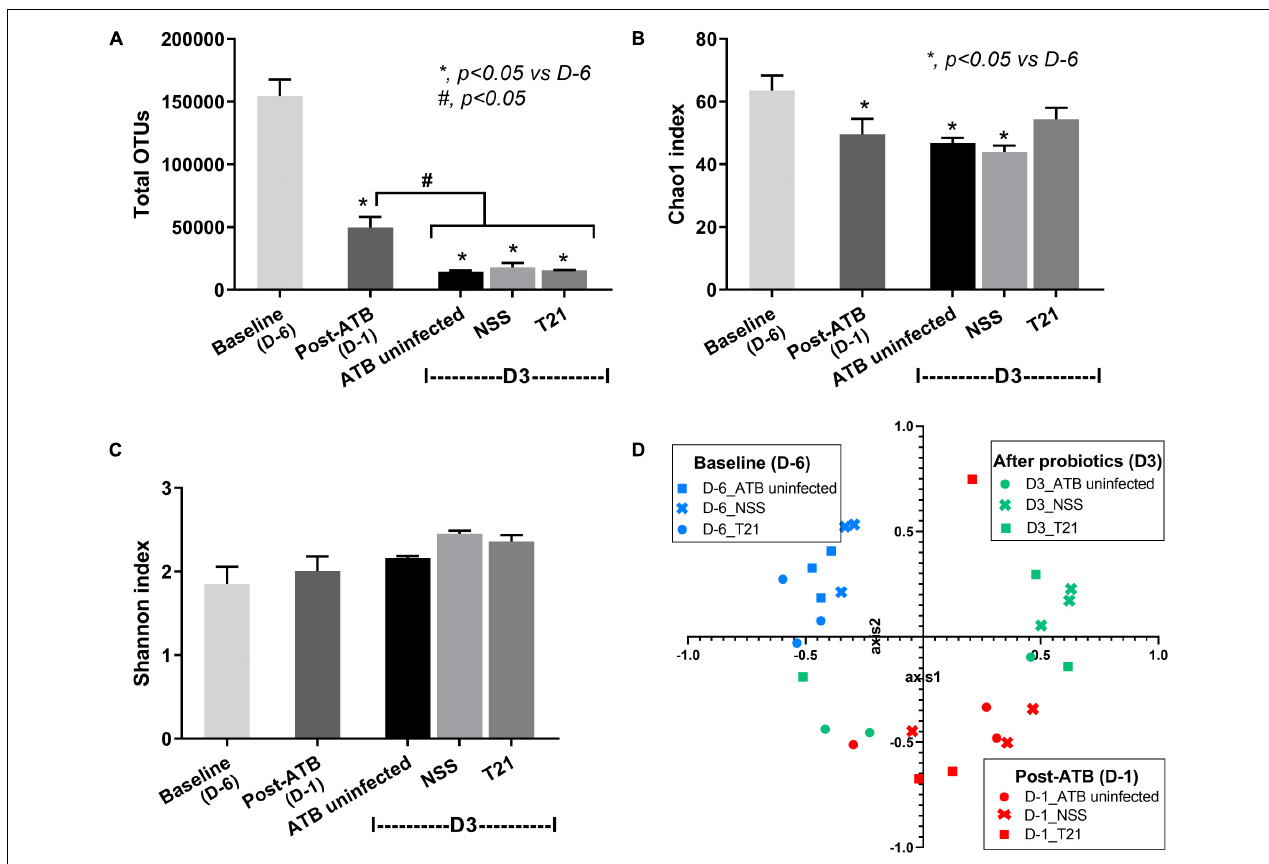
FIGURE 4 | Diversity of gut microbiota in each group of mice at multiple time points. Fecal microbiome data of the ATB uninfected, NSS, and T21 groups ( n = 3/group) at baseline, post-ATB, and at sacrifice were calculated for microbial diversity and presented as total operational taxonomic units (OTUs) (A) , Chao1 index (B) , Shannon index (C) , and the non-metric multidimensional scaling (NMDS) based on Thetayc dissimilarity (D) . Independent triplicate experiments were performed. *p < 0.05 vs. D-6, # p <